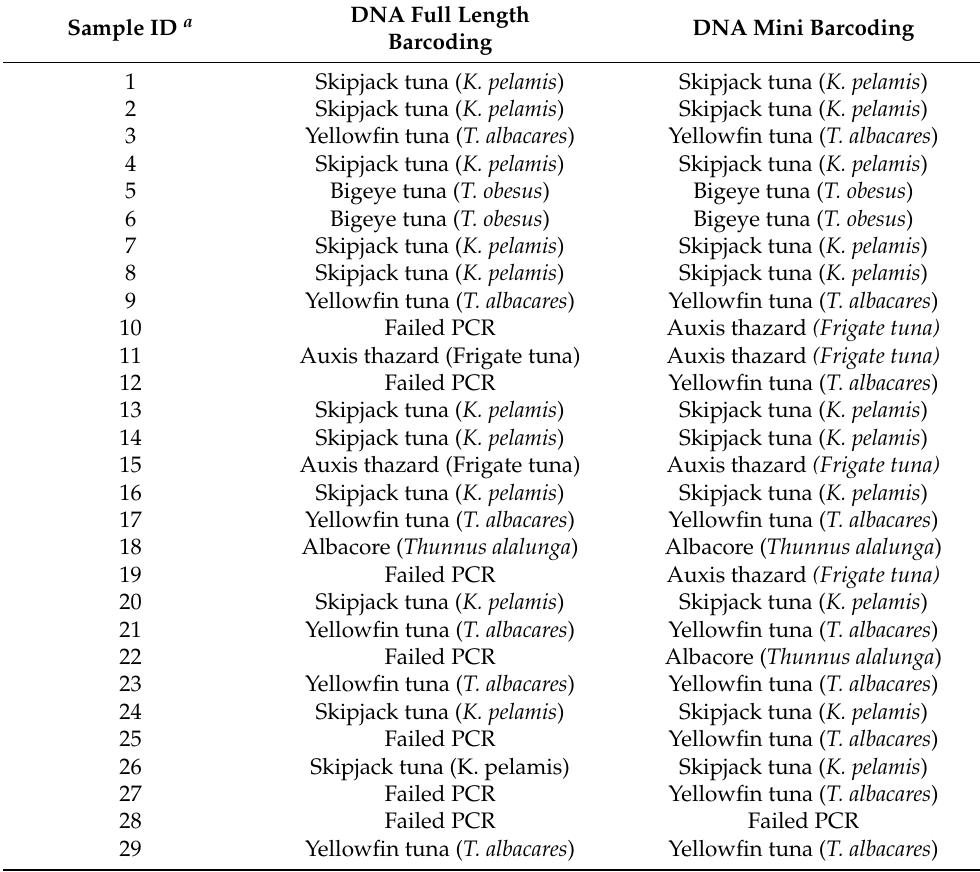
Table 5. Identified species by DNA-barcoding and DNA